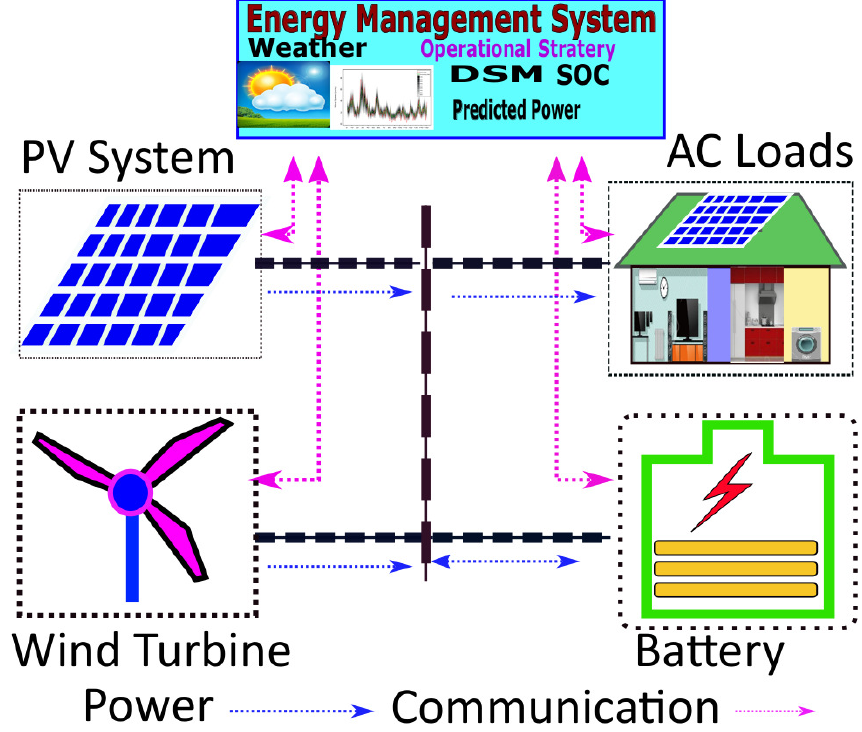
Figure 1. Proposed schematic view of the